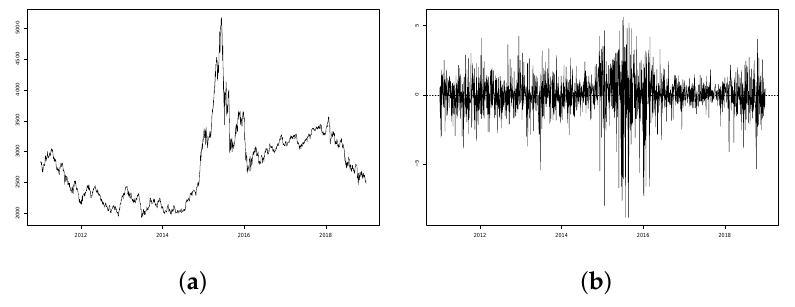
Figure 1. SSE Index. ( a ) Closing prices. ( b )